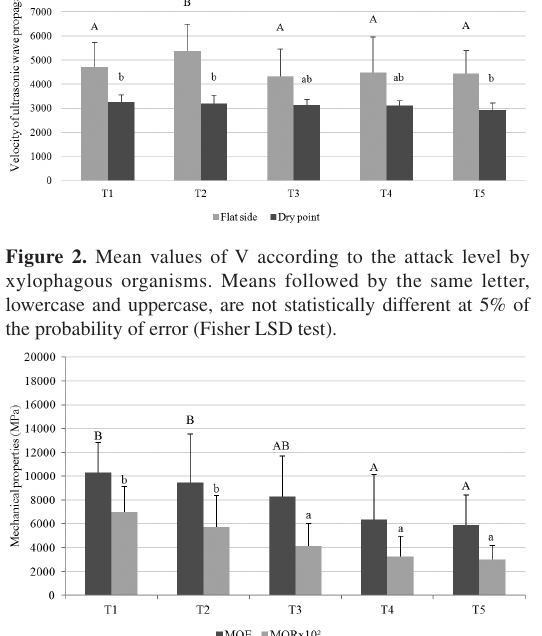
Figure 3. Mean values of MOR and MOE according to the attack level by xylophagous organisms. Means followed by the same letter, lowercase and uppercase, are not statistically different at 5% of the probability of error (Fisher LSD test).